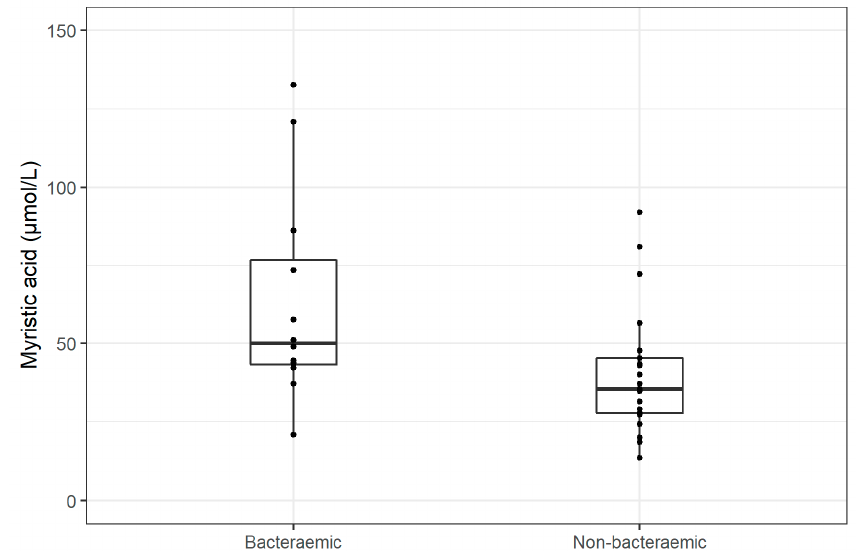
Figure 3. A comparison of myristic acid levels on admission in septic patients with and without bacteraemia.